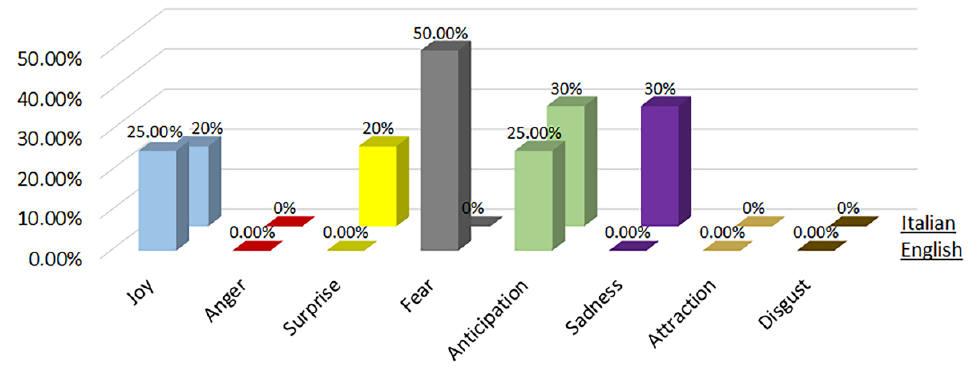
Figure 10. Rating of the most-cited words in English and Italian during phase 2 of COVID-19 pandemic (green is positive, red is negative).